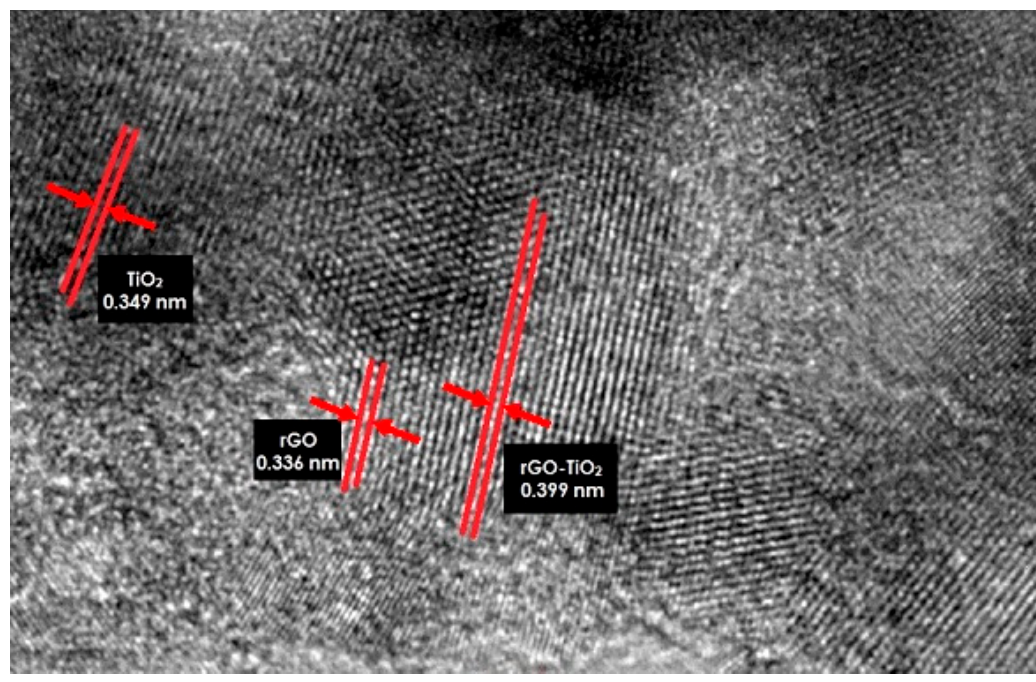
Figure 5. HRTEM image of 120 °C sputtered temperature of rGO-TiO 2 nanocomposite.